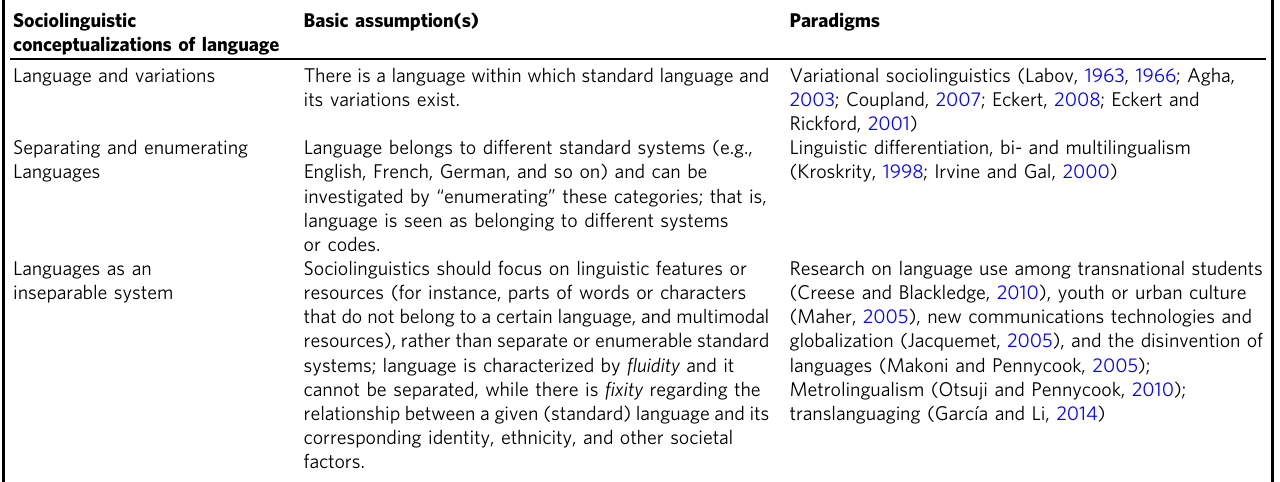
Table 1 Different conceptualizations of language as a verbal form in social